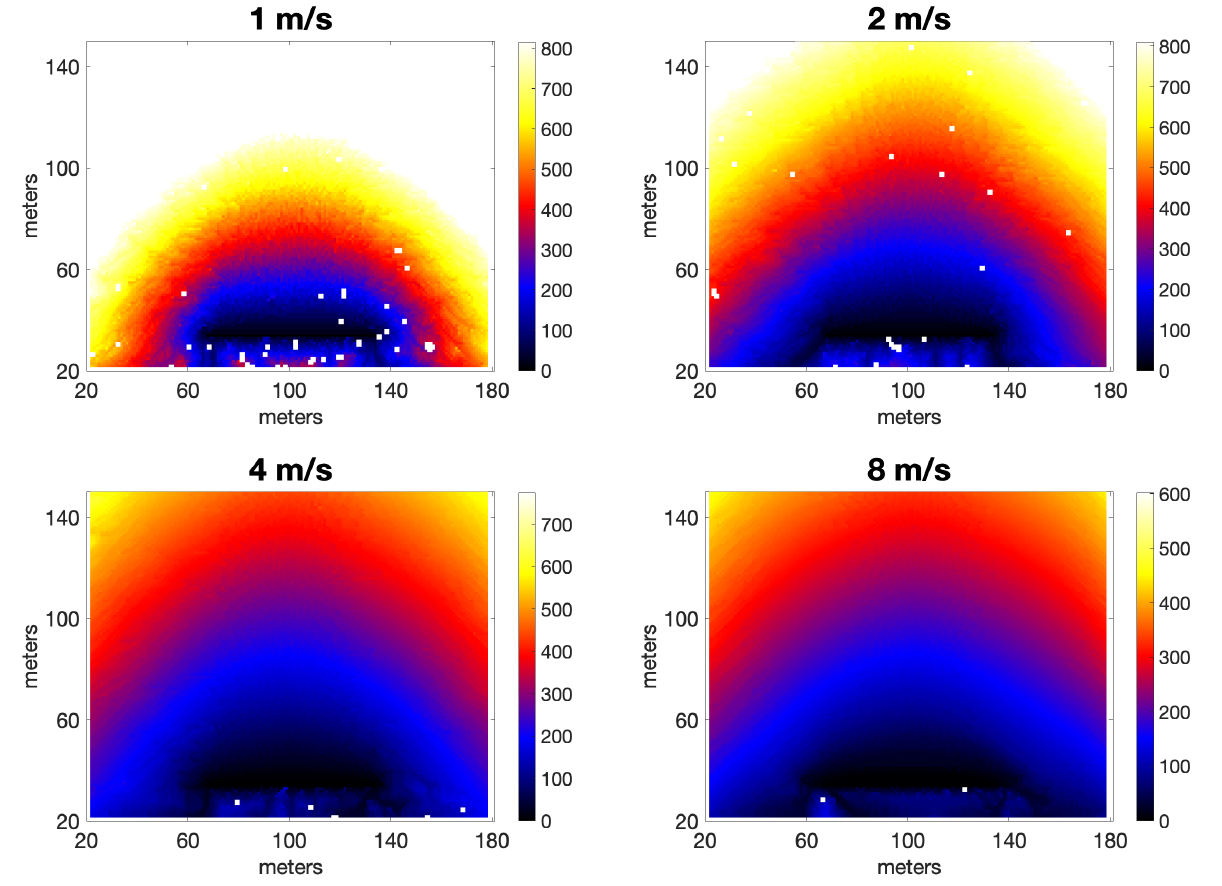
Figure 9. The first arrival time, in seconds, of a head fire with a background wind U BG and burn time τ b = 15 s. The buoyant plume is relatively weak with U sink = 3.63 × 10 − 3 , and the fire-induced vortical flow is 100 times larger with U vort = 3.63 × 10 − 1 .